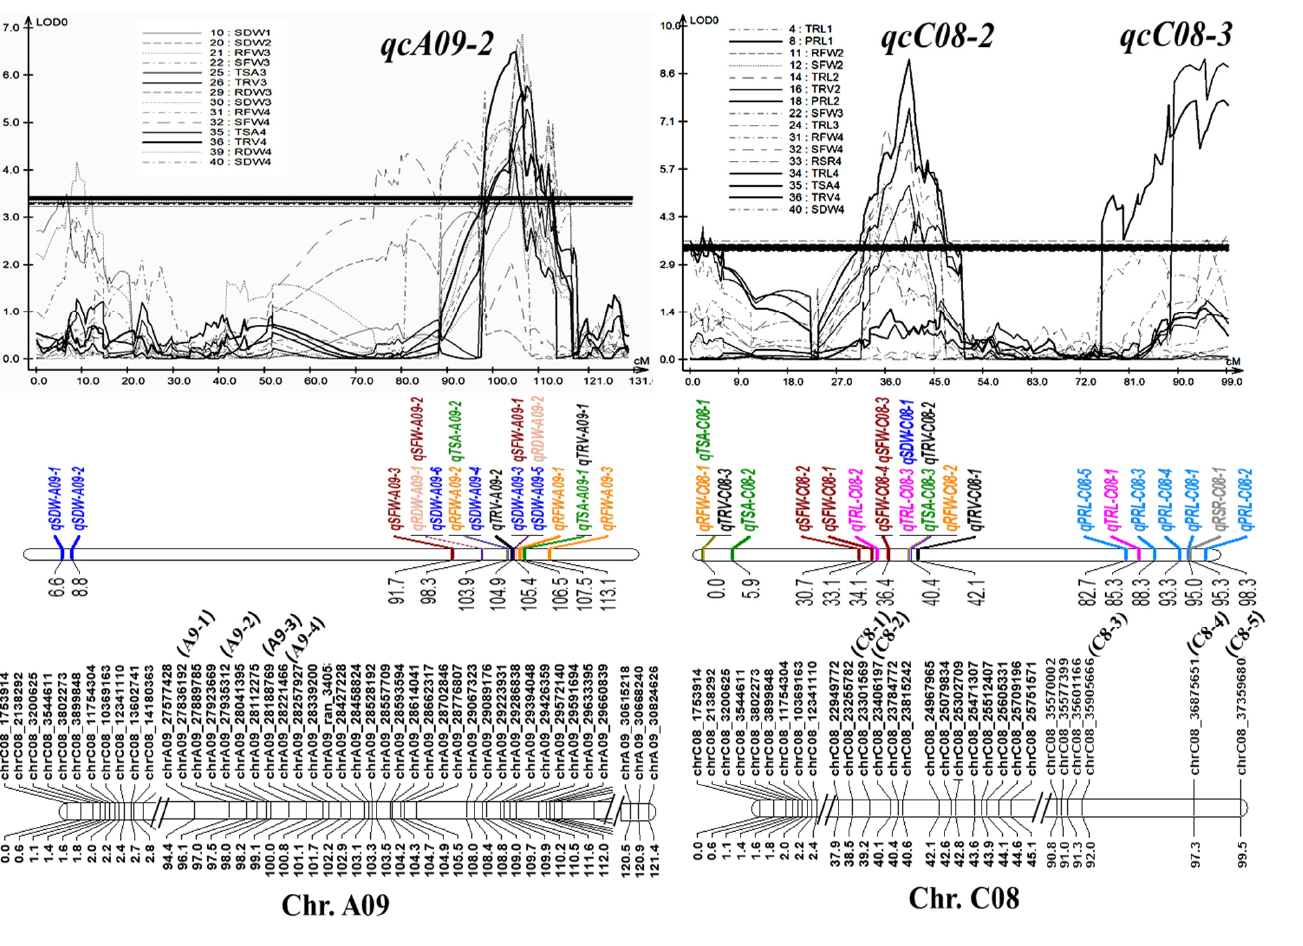
Figure 4. Information of the three major QTL clusters, qcA09-2 , qcC08-2 , and qcC08-3 . Three major QTL clusters with their involved QTLs, LOD curves, and SNP markers at the corresponding linkages. SNPs noted with other names, A9-1, A9-2, A9-3, A9-4, C8-1, C8-2, C8-3, C8-4, and C8-5, were converted into PARMS markers.